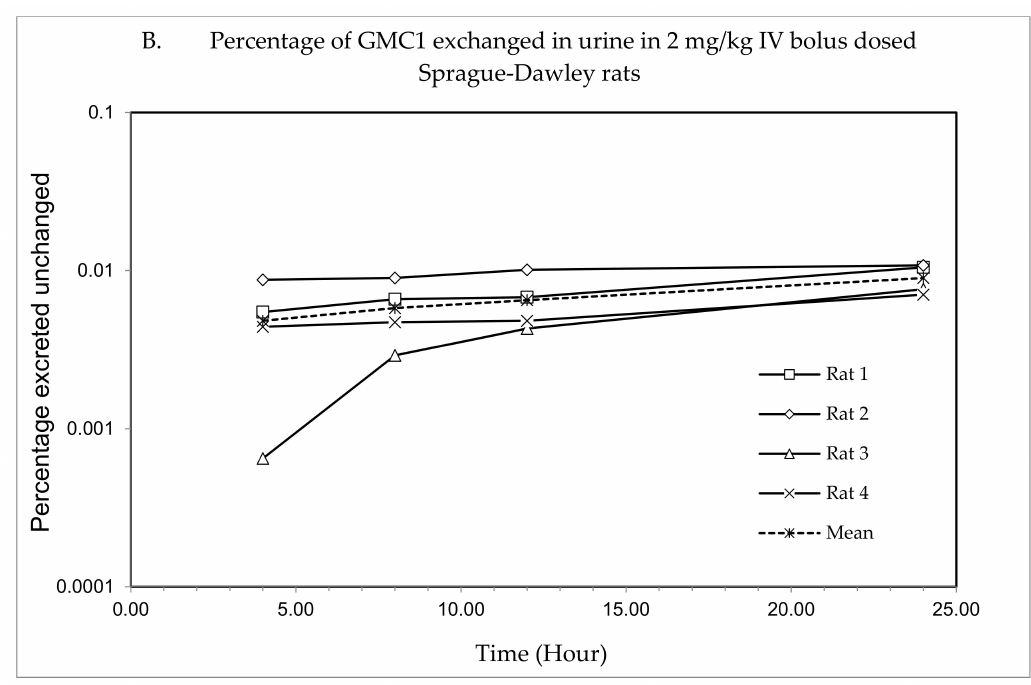
Figure 3. Pharmacokinetic study of GMC1 in adult male Sprague-Dawley (SD) rats ( n = 4; average body weight = 0.33 ± 0.005 kg). ( A ) Plasma concentration—time profiles of GMC1 following a 2 mg / kg i.v. bolus dose, ( B ) Cumulative percentage of the administered dose of GMC1 excreted unchanged in